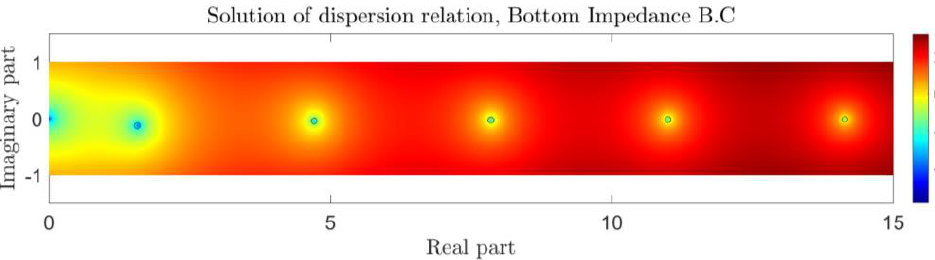
Figure 14. The solution of the eigenvalue Equation (55) in the isovelocity case and small values of the impedance parameter ˆ A = 0.001 on the complex plane, and the comparison of the exact and approximate solutions given by Equation (59) shown using black circles.